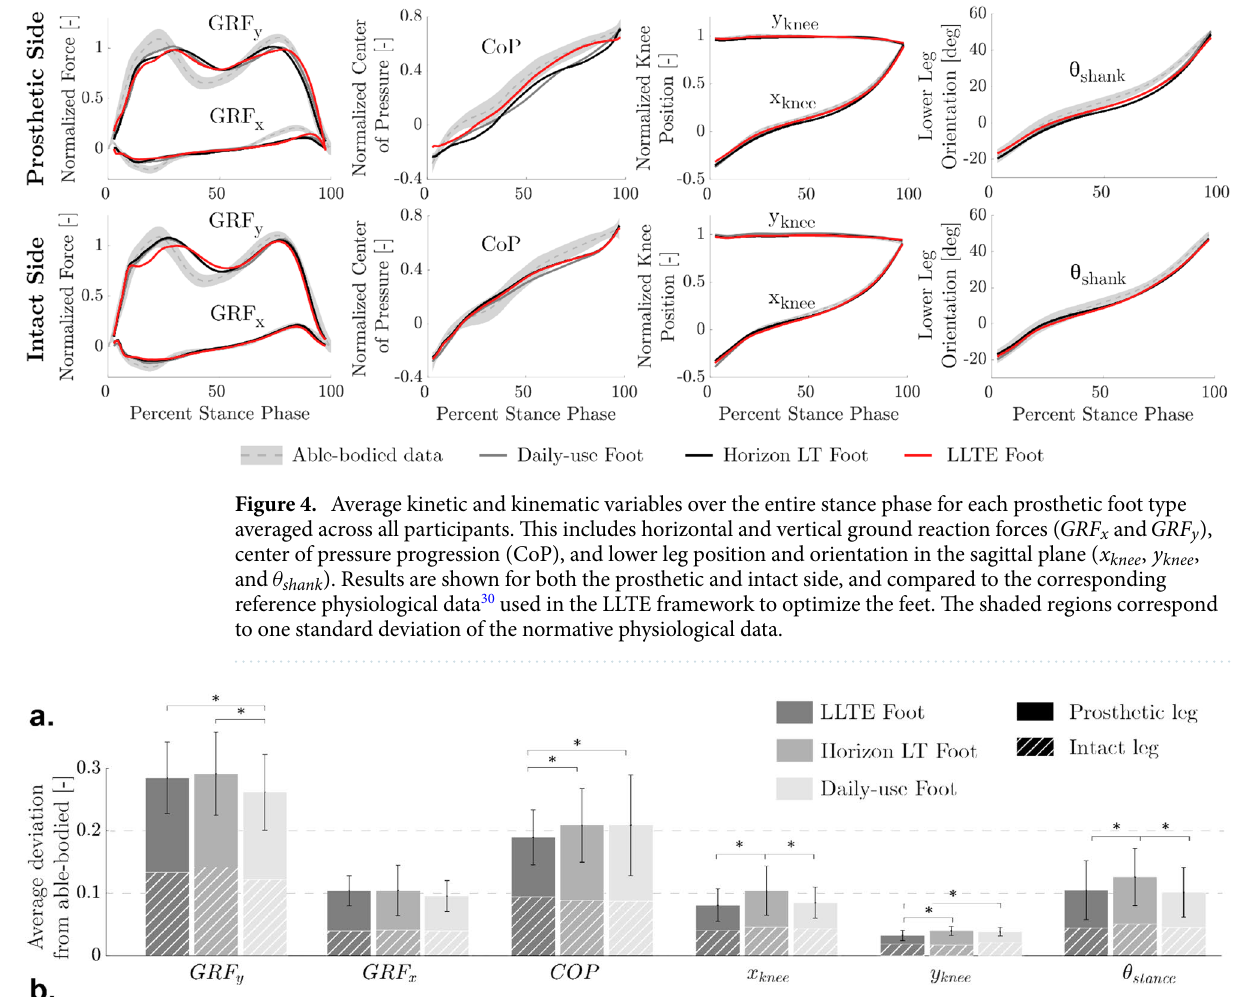
Table 2). The LLTE feet led to a reduced peak plantarflexion angle during the loading response at heel strike over the Horizon LT ( p < 0.001 ) and daily-use feet ( p < 0.001 ). Overall the foot range of motion with the LLTE feet was similar to the Horizon LT feet ( 16.5 ◦ and 16.4 ◦ , with p = 0.882) but smaller than the daily-use feet ( 19.8 ◦ with p = 0.002).